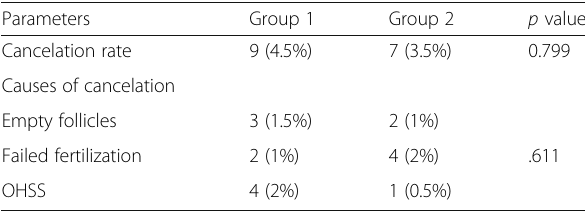
Table 1 Comparison of cancelation rate and causes of cancelation in both groups